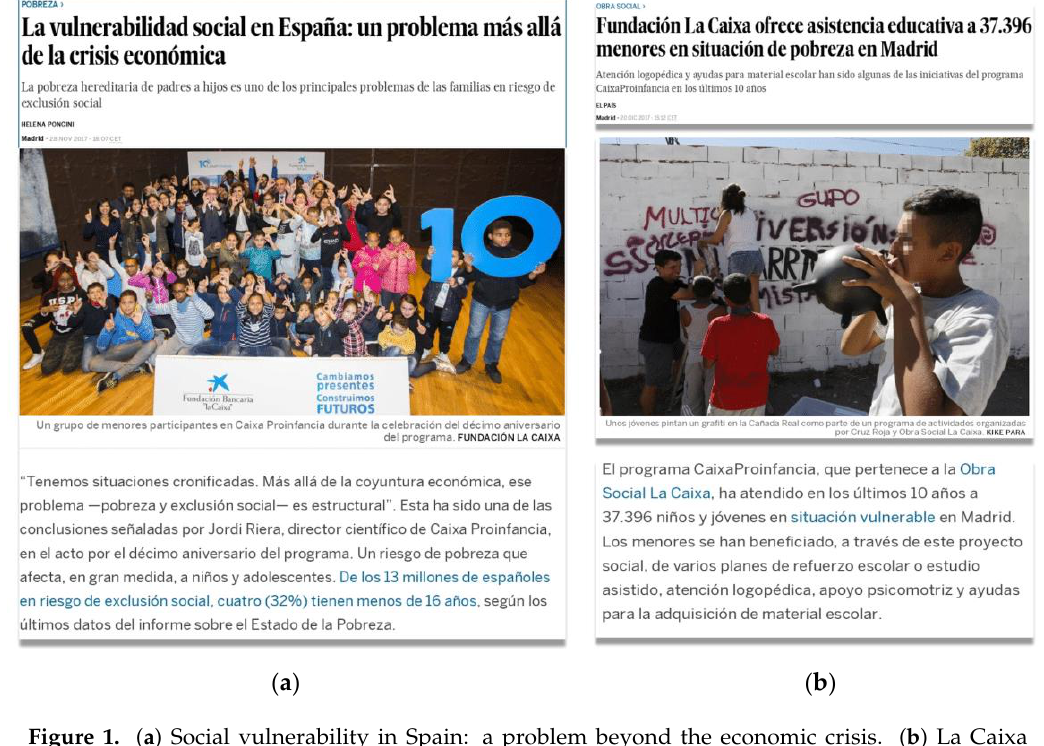
Figure 1. ( a ) Social vulnerability in Spain: a problem beyond the economic crisis. ( b ) La Caixa Foundation offers educative assistance to 37,396 minors in a situation of poverty in Madrid. Pieces of news presented in the activity 1.